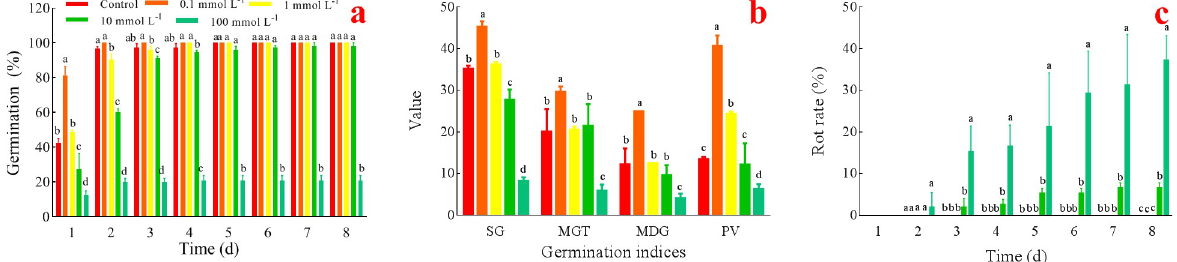
Fig 1. Effects of AsA on germination (a), germination indices (b), and rot rate (c). Lower case letters indicate the difference in each group. The significance level is 0.05, the same below.